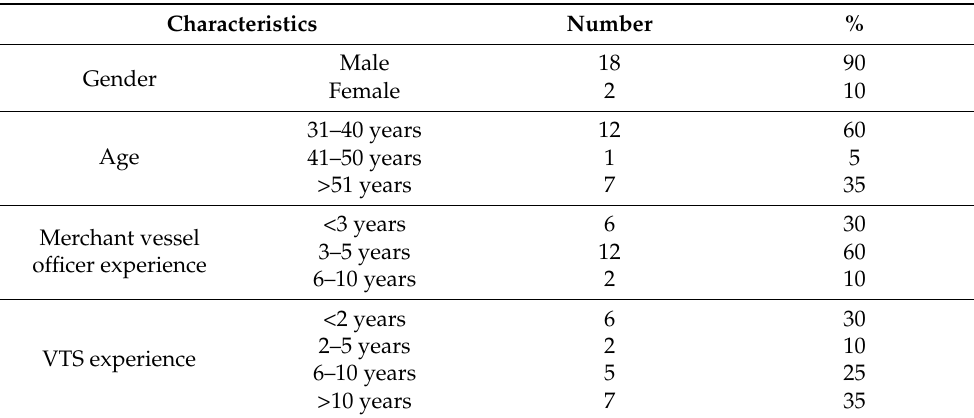
Table 1. Questionnaire participants